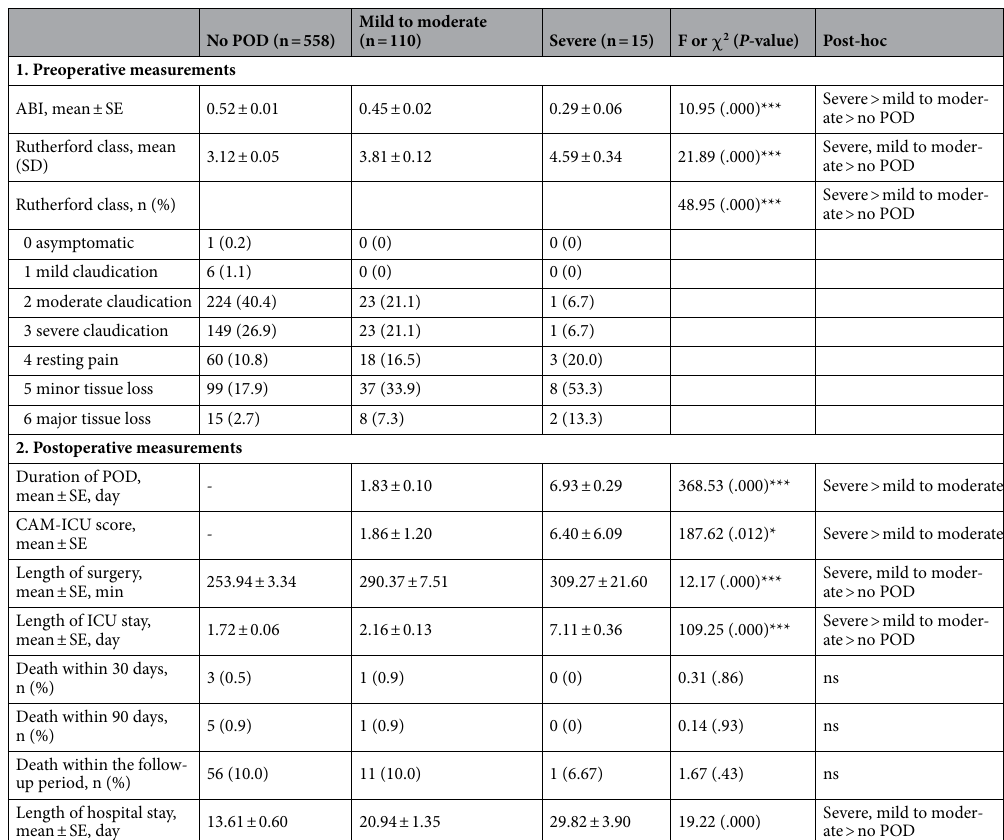
Death within 30 days, n (%)